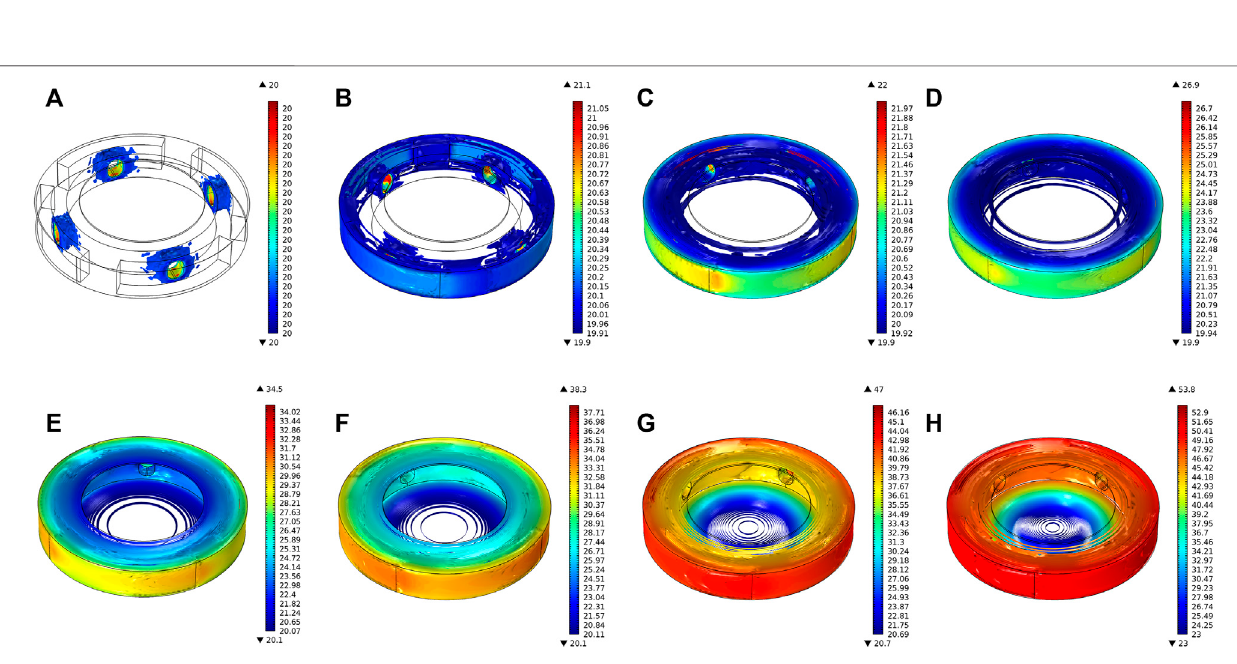
Frontiers in Materials |